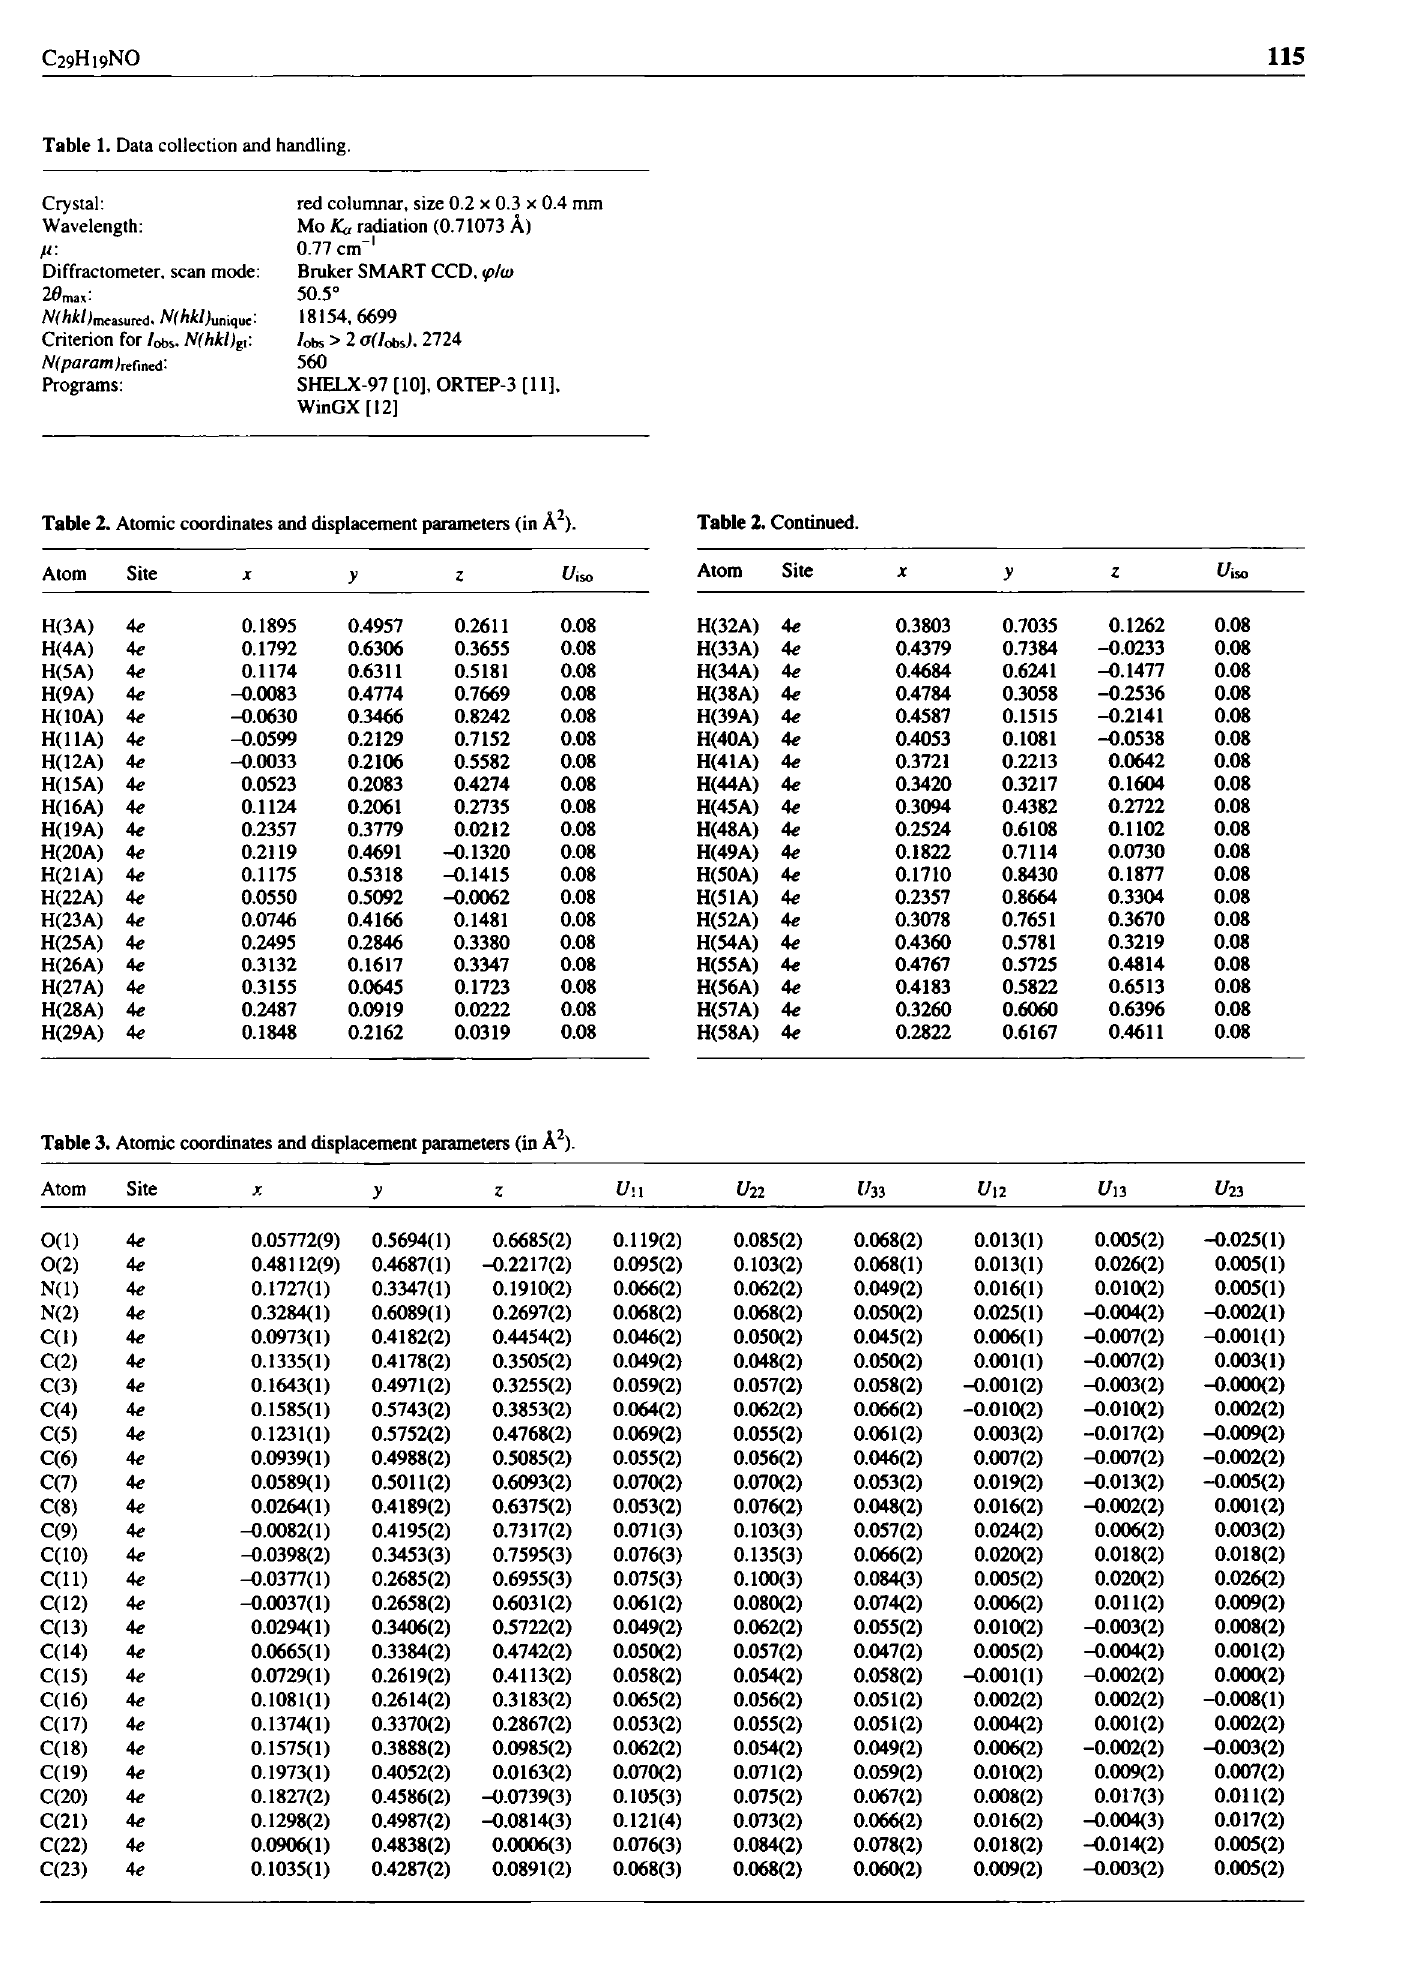
Table 1. Data collection and handling.